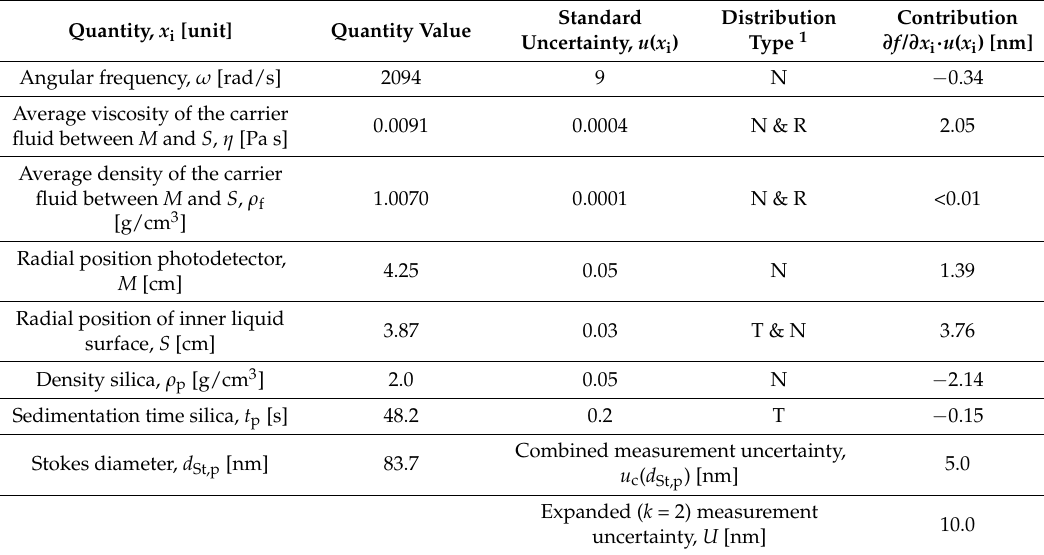
Figure 5. Fishbone diagram illustrating the potential sources of uncertainty for particle size measurements performed with the reference disc-CLS method. Table 4. Uncertainty budget for a single disc-CLS measurement (reference method) of nominally 80 nm silica nanoparticles